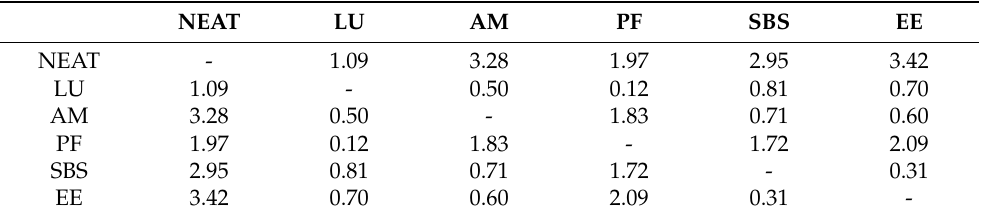
Table 15. Effect sizes for TSR.